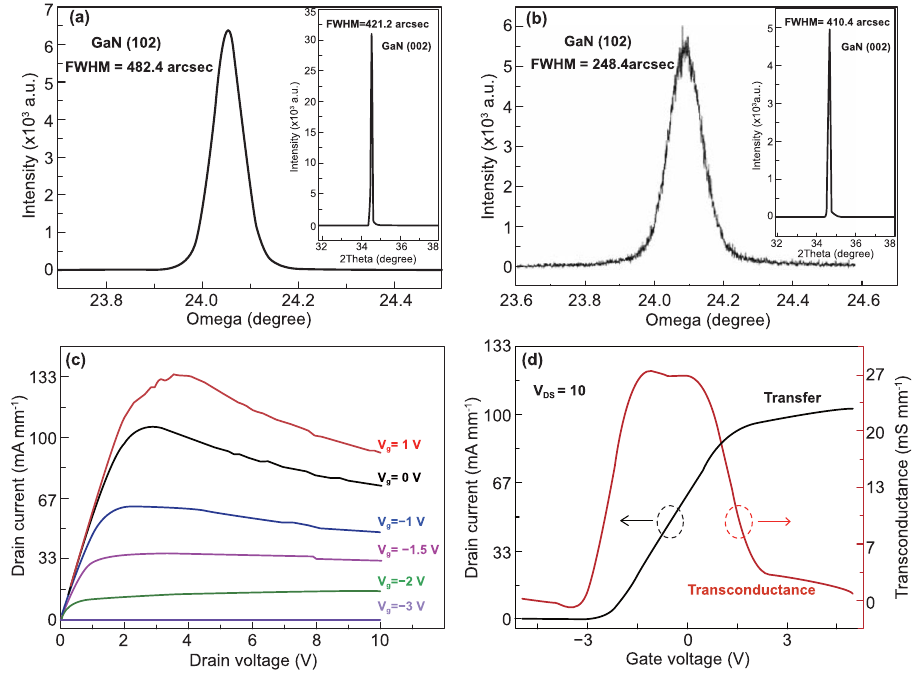
Fig. 4 The crystal quality and electrical properties of flexible HEMTs. a The full width at half maximum (FWHM) of the GaN material meas- ured by HRXRD of the AlGaN/AlN/GaN HEMTs on sapphire, and b on flexible PET. c Output curves under different gate voltages and d trans- fer characteristics of flexible